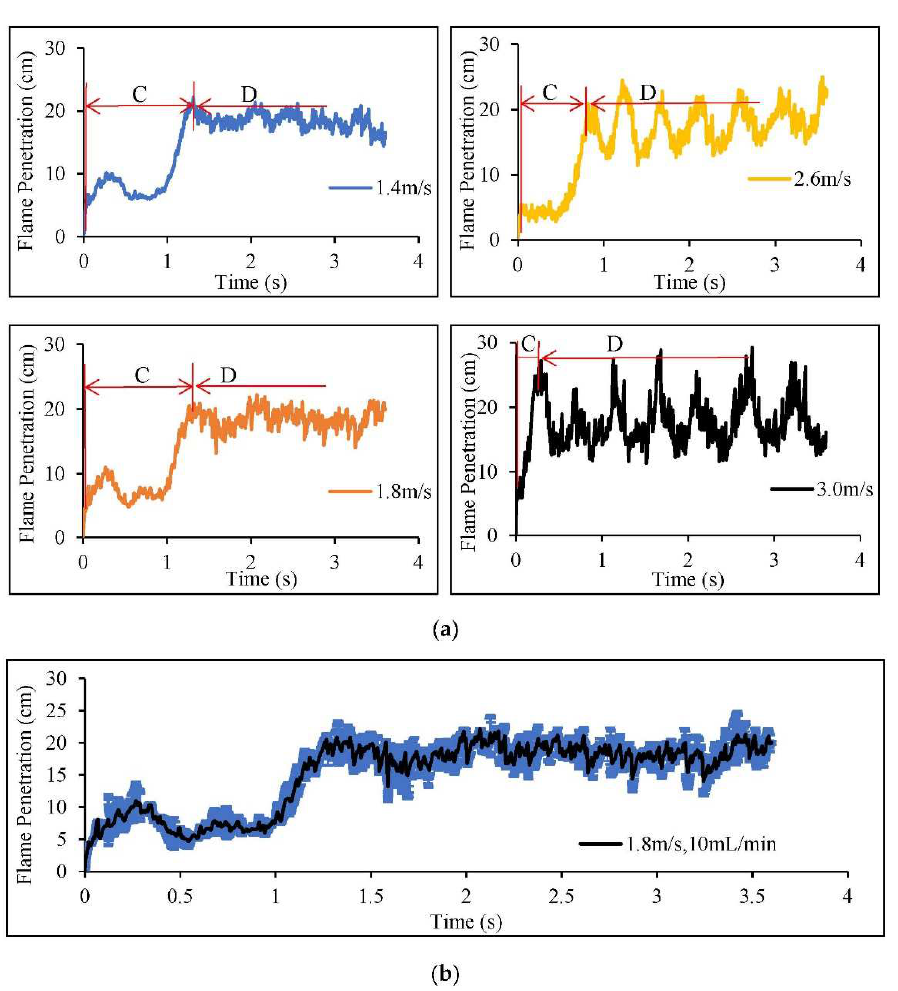
Figure 9. ( a ) Flame penetration under different air flow velocities with the diesel flow rate of 10.0 mL/min and ( b ) the error bar under 1.8